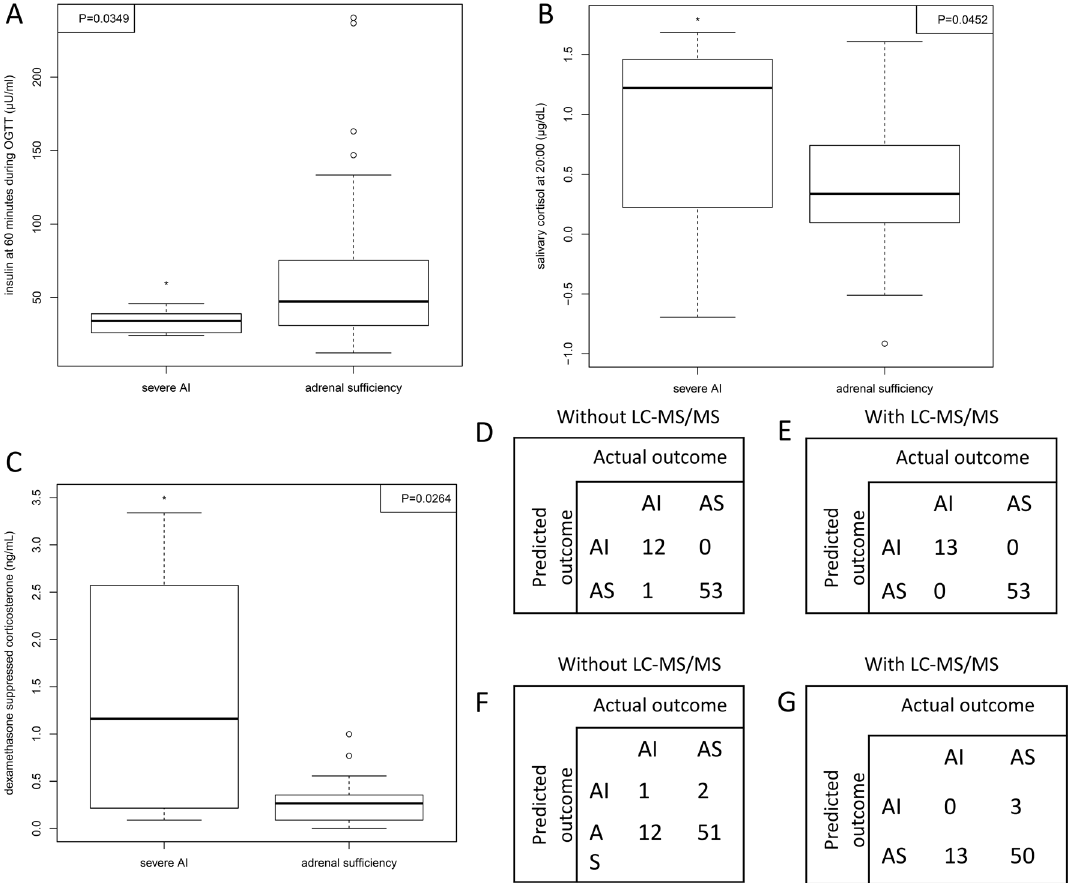
Figure 2. Boxplots of differences between severe AI and adrenal sufficiency groups in individual variable ( A – C ); the classification of gradient tree boosting model in training data ( D,E ) and cross validation ( F,G ). *Represent p value smaller than 0.05, namely significant difference. Boxplot of pre-operative insulin at 60 min during oral glucose tolerance test (OGTT) ( A ). Boxplot of salivary cortisol at 20:00 ( B ). Boxplot of dexamethasone suppressed corticosterone ( C ).